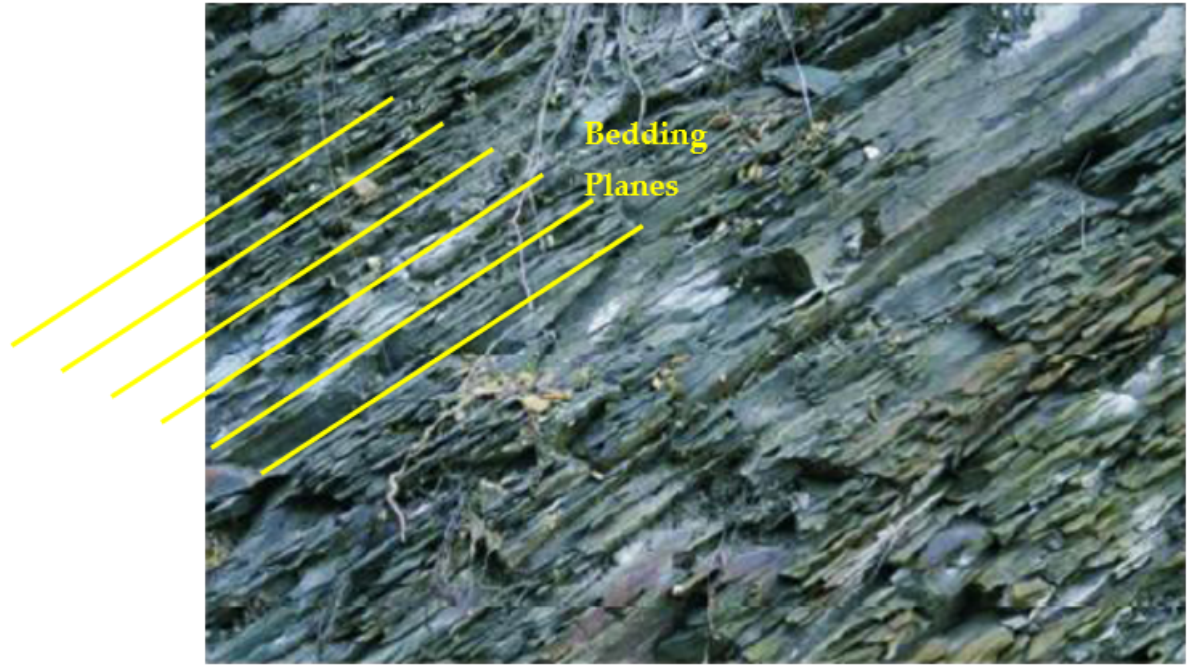
Figure 1. Bedding planes in an outcrop of the Longmaxi shale formation.